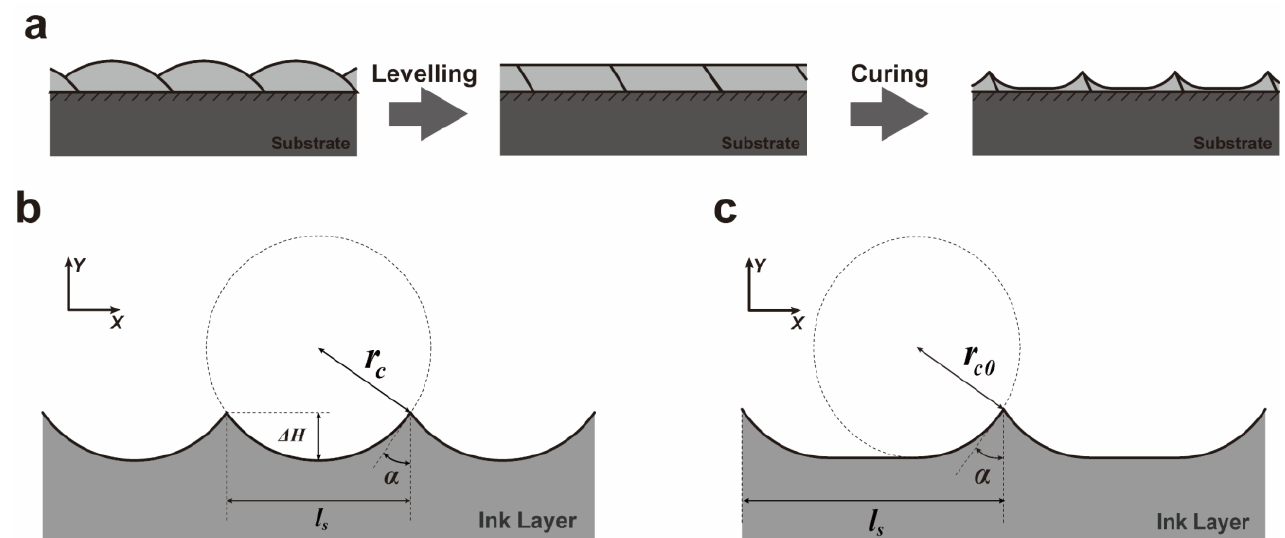
Figure 6. ( a ) Curing process of layer surface after printing. After printing the layer surface, the ink will flatten into a relatively smooth surface. Upon curing, the layer surface will exhibit aligned ripples. ( b ) Schematic diagram of the layer surface geometry model when l s is less than l s 0 . ( c ) Schematic diagram of the layer surface geometry model when l s is greater than l s 0 .